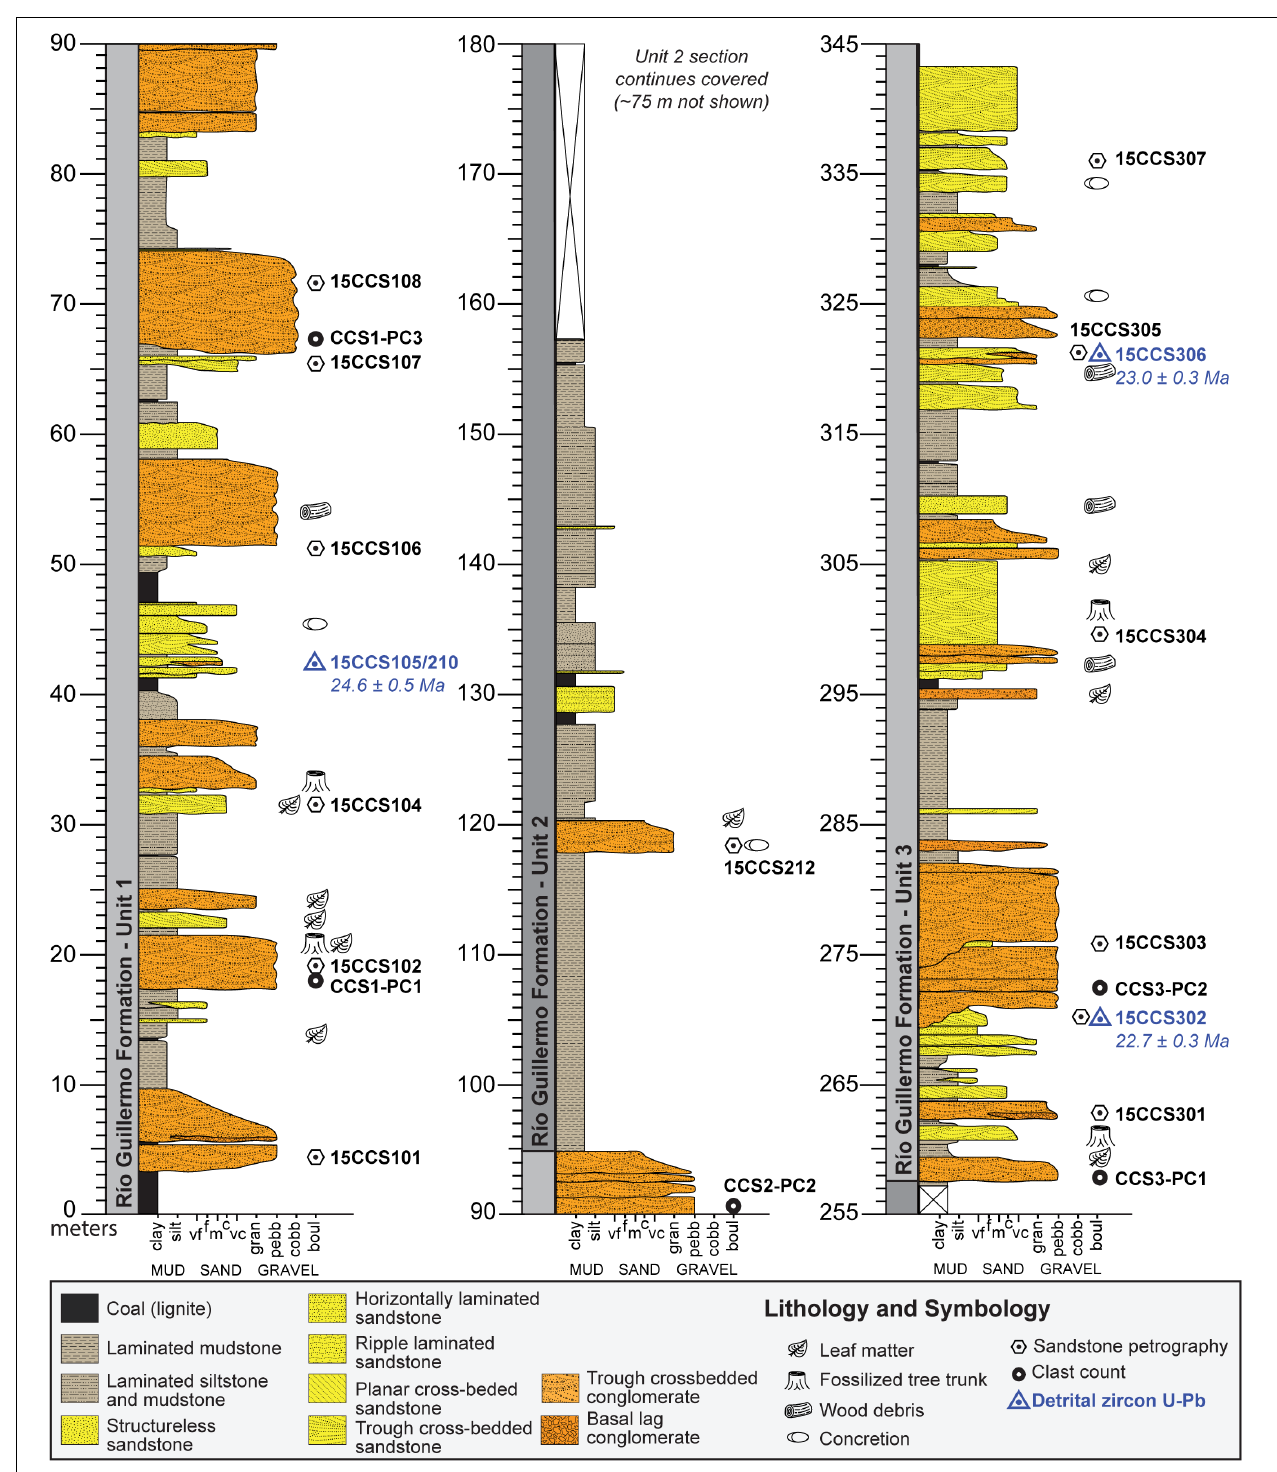
FIGURE 3 | Measured stratigraphic section of the Río Guillermo Formation at Cancha Carrera, Argentina, with sample locations for sandstone petrography, modal clast analysis, and detrital zircon U-Pb geochronology. We subdivide the formation into three major units based on sedimentology and stratigraphic architecture. Maximum depositional ages (blue triangles) interpreted from the detrital zircon U-Pb data are reported at 2 σ . See text for detailed descriptions. Locations of measured section: Base 51.31259 ◦ S, 72.22169 ◦ W; Top 51.30823 ◦ S, 72.19668 ◦ W.